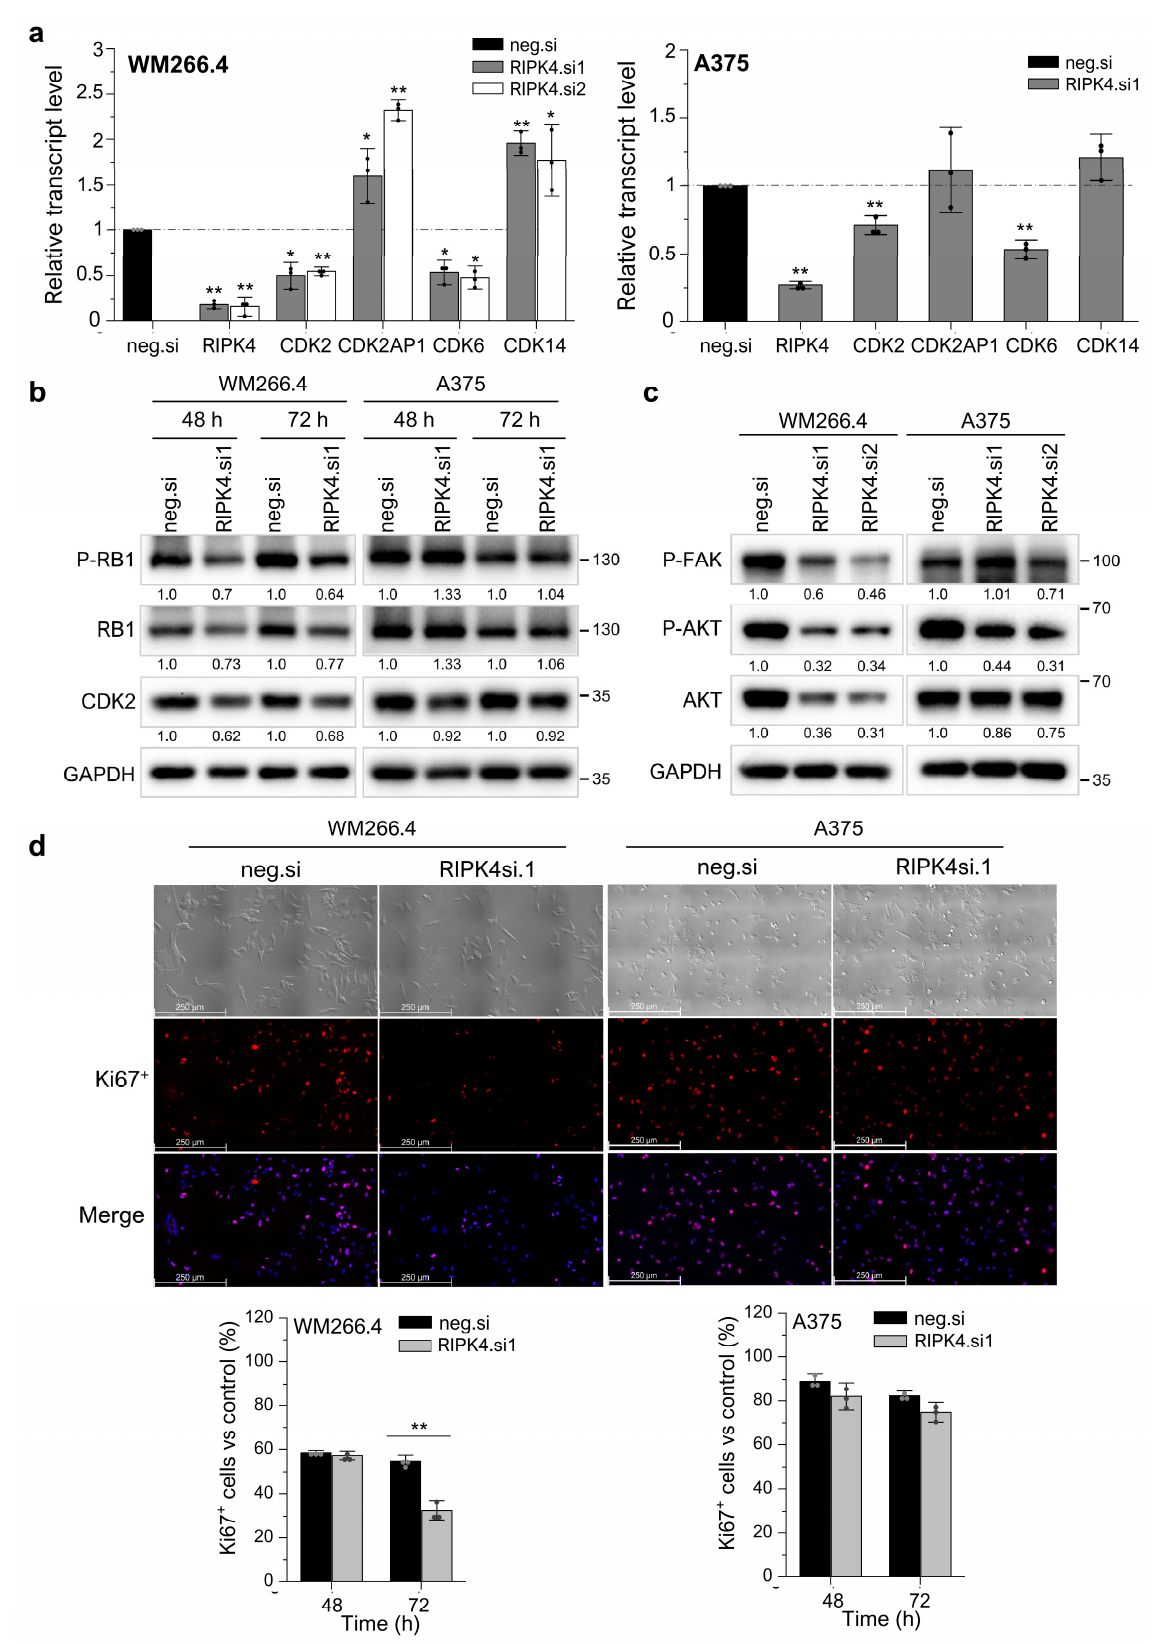
Figure 7. Downregulation of RIPK4 alters proliferation in WM266.4, but not in A375 cells. WM266.4 and A375 cells were transfected with RIPK4.si1, RIPK4.si2, or neg.si RNA and analyzed, n =